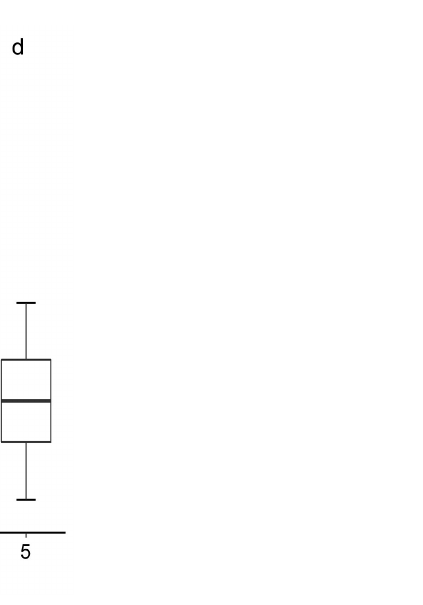
Figure 3. Number of species in the seed bank as a function of distance to the field edge. Significant pairwise differences are indicated by different letters (pairwise comparisons, p -value ≤ 0.05, Tukey-corrected).